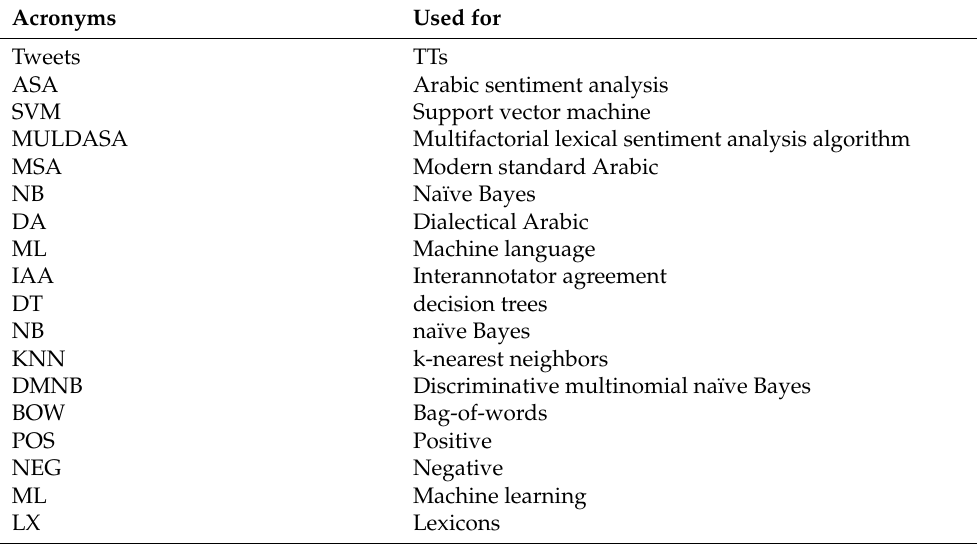
Table 1. Definitions of used